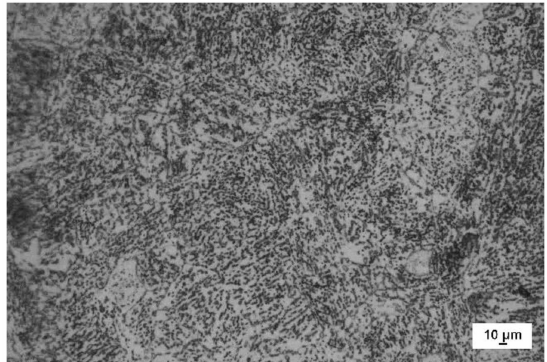
Figure 4. Optical micrograph of steel 1.7225; as - received material, soft annealed, cross - section of the specimen, 4% nital, 1000 ˆ